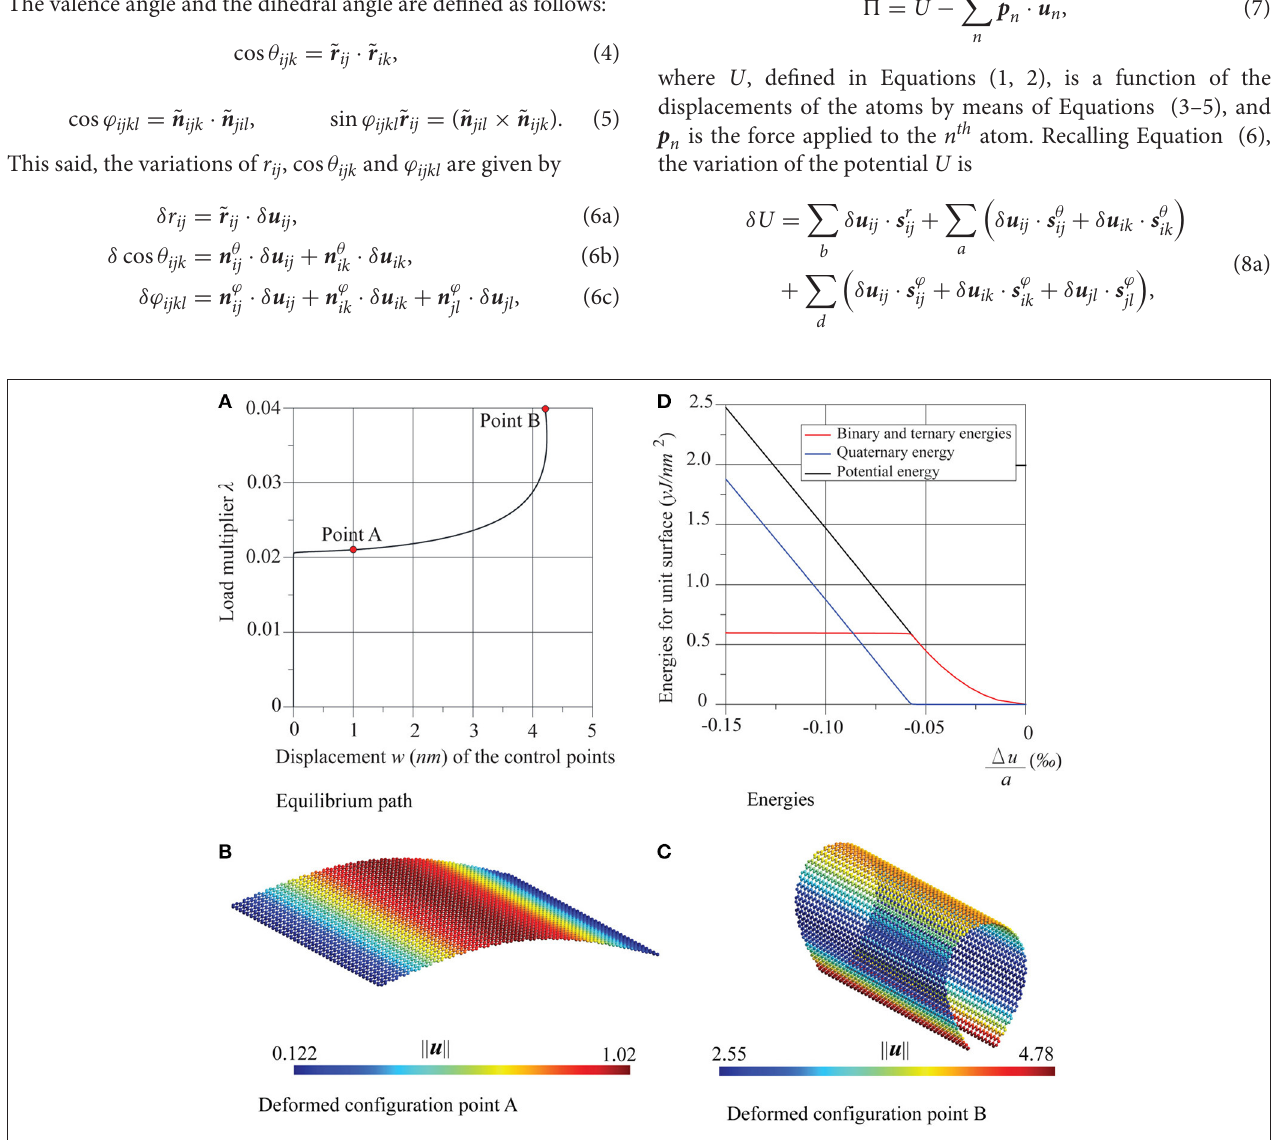
FIGURE 3 | Graphene sheet with two supported edges under compression in the zigzag direction: (A) equilibrium path, (B,C) deformed configurations at the points A and B , and (D) energies trends.